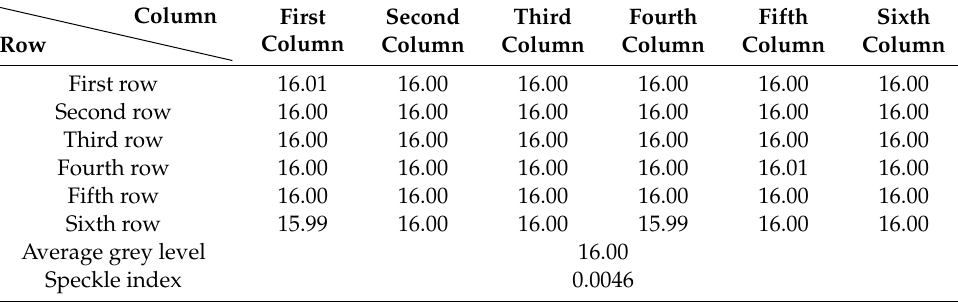
Table 3. The average gray value corresponding to the sample point after